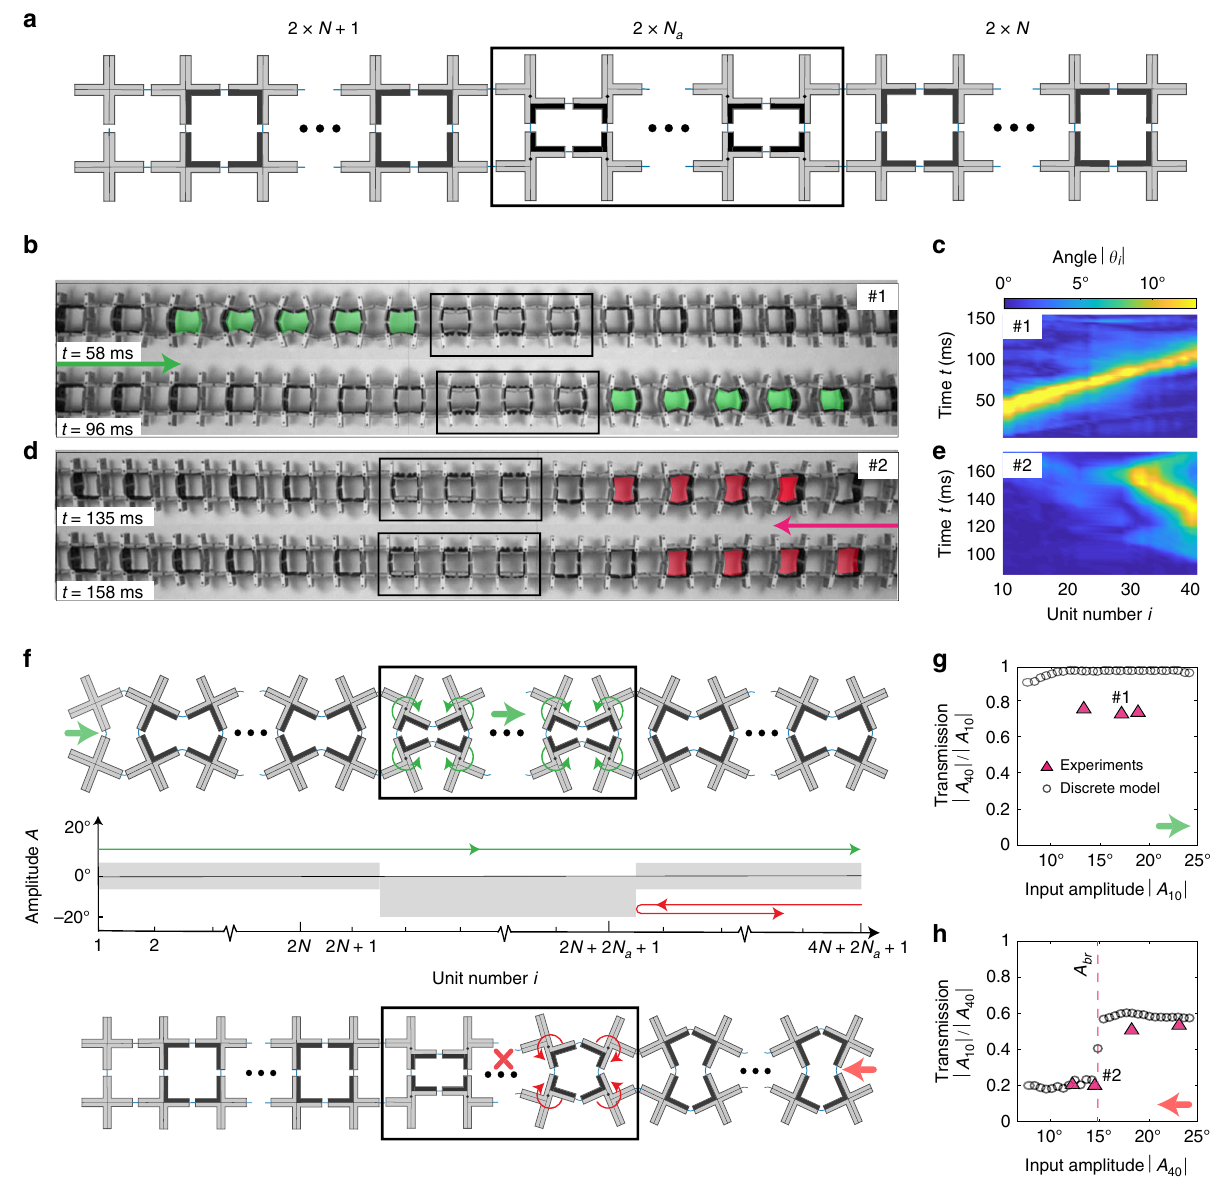
Fig. 4 Mechanical diode. a Schematics of our mechanical diode. b Optical images showing the propagation of a solitary wave excited at the left end of the chain. c Rotation of the pairs of crosses induced by a pulse excited at the left of the chain. d Optical images showing the propagation of a solitary wave excited at the right end of the chain. e Rotation of the pairs of crosses induced by a pulse excited at the right of the chain. f Schematic highlighting the working principles of our mechanical diode. g Measured transmission, A 40 = A 10 j j , as a function of the input amplitude, A 10 j j , for pulses excited at the left = A j j , as a function of the input amplitude, A j j , for pulses excited at the right end of the end of the chain. h Measured transmission, A 10 40 40